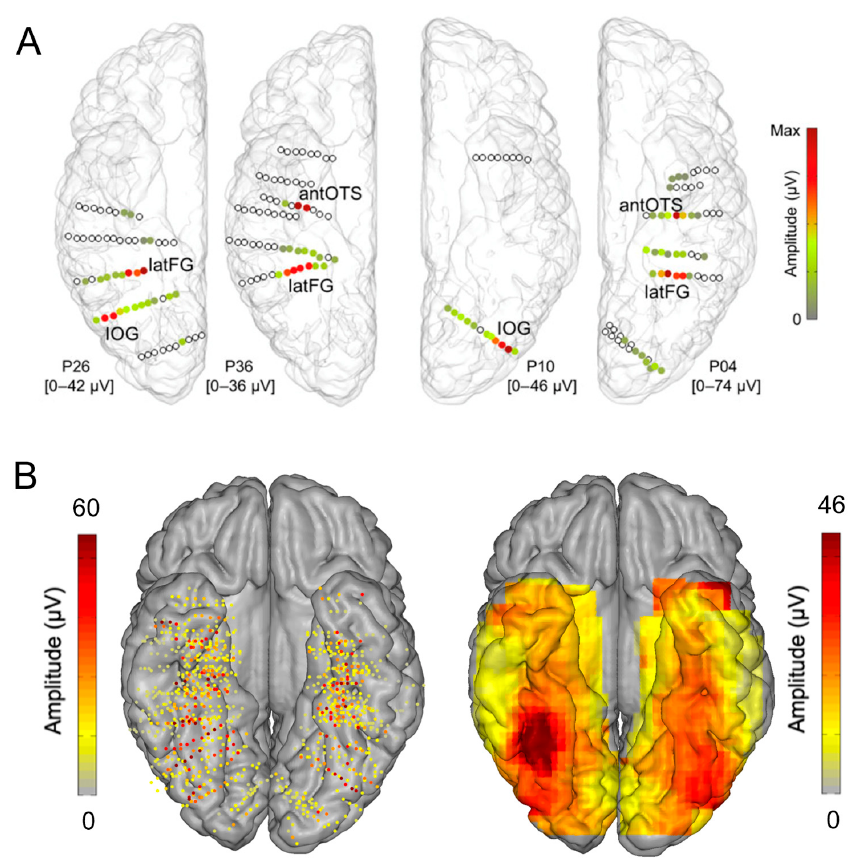
Figure 6. ( A ) Quantification of face-selectivity in individual brains Individual level. Contacts were color-coded according to their relative face-selective amplitude in four participants. ( B ) Quantification of face-selectivity at the group level in a common space. Significant contacts across 84 subjects were color-coded according to their relative face-selective amplitude and displayed in the Talairach space (left panel). Amplitude across contacts can also be smoothed and projected on the cortical surface by plotting the mean face-selective amplitude within 15 mm × 15 mm voxels (right panel). The peak of activity is found at Talairach coordinate x = 38, y = − 47, z = − 15, which is only slightly anterior to the average coordinate reported in the seminal study of Kanwisher et al. (1997) [67] (x = 40, y = − 55, z = − 10), and in a more recent fMRI study with the same stimuli and frequency-tagging approach (Gao et al., 2018 [69]: x = 42, y = − 54, z = − 14).